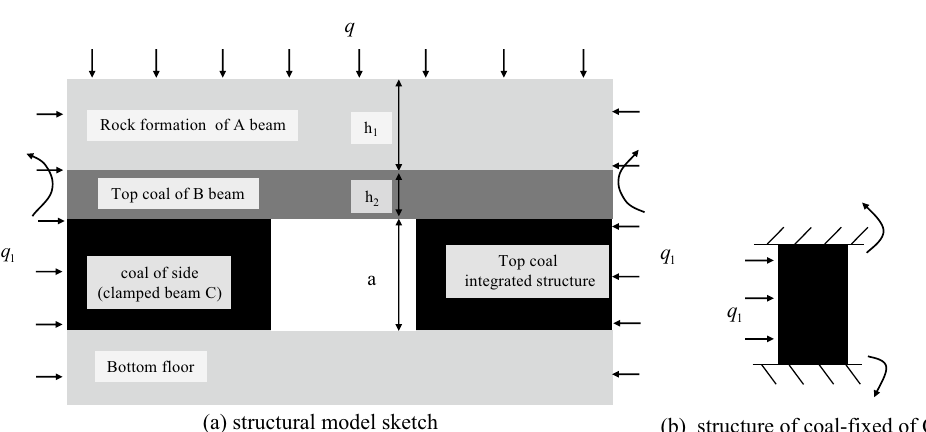
Figure 1. Structural model of the top coal roadway in thick